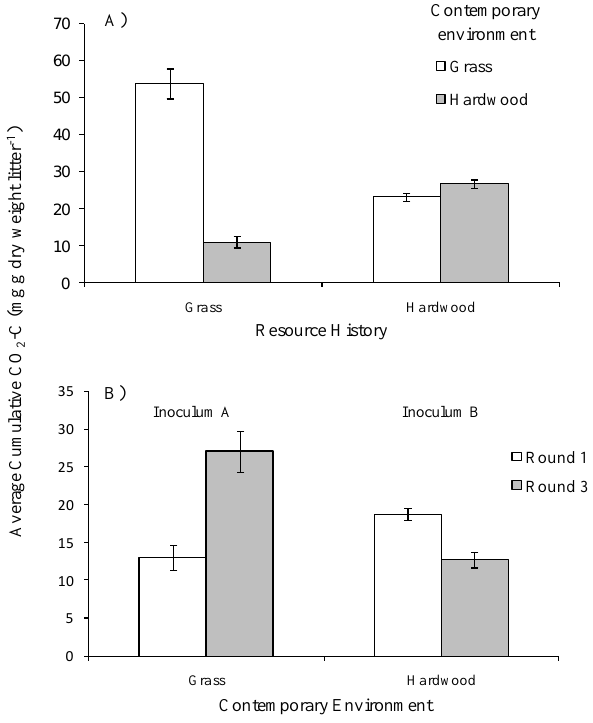
Fig. 4. Cumulative litter decomposition for inocula exposed to grass or hardwood litter environments and then placed in the same envi- ronment or switched into the alternate environment. In (A) , expo- sure to the grass litter environment in rounds 1 and 2 (resource his- tory) leads to reduced decomposition in the hardwood compared to the grass litter environment in round 3 (contemporary environment), but no such loss of function is associated with history of exposure to the hardwood environment when inocula are placed into the two environments in round 3. Values are means ± 1SE ( n = 36). In (B) , the function of a single inoculum, (A or B) on a single litter type (grass or hardwood, respectfully), is compared between rounds 1 (white bars) and 3 (grey bars). The round 1 inocula are sourced from the same field location used to construct the microcosms (pre- experimental). After two rounds in hardwood litter, inoculum A increases function in a grass environment as compared to round 1 (a pre-experimental history of grass). In contrast, after two rounds in grass litter, inoculum B decreases function in a hardwood en- vironment as compared to round 1 (a pre-experimental history of hardwood). Values are means ± 1SE ( n =